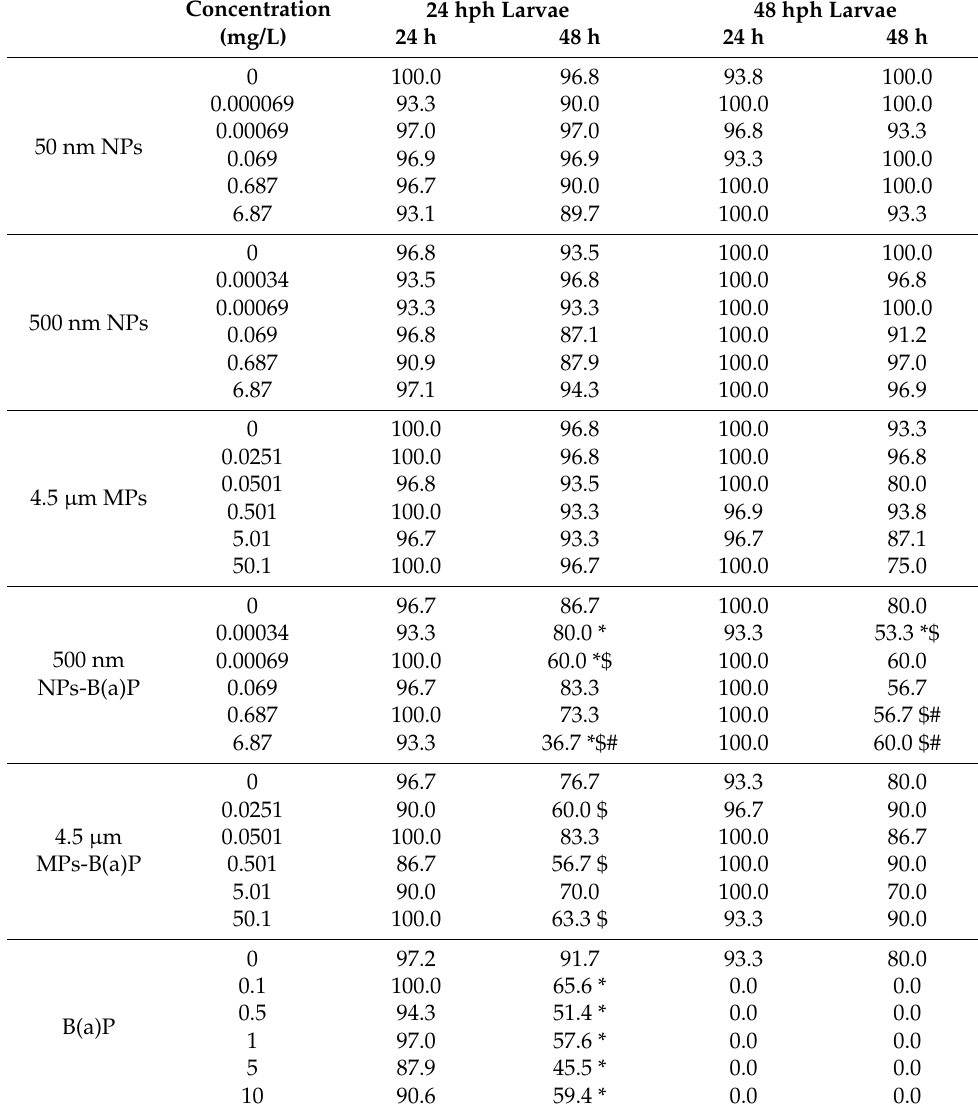
Table 3. Effects on survival (percentage over the whole sample, n = 30 individuals) of the 24 h and 48 h exposures to NPs and to MPs alone and with sorbed B(a)P of 24 hph and 48 hph brine shrimp